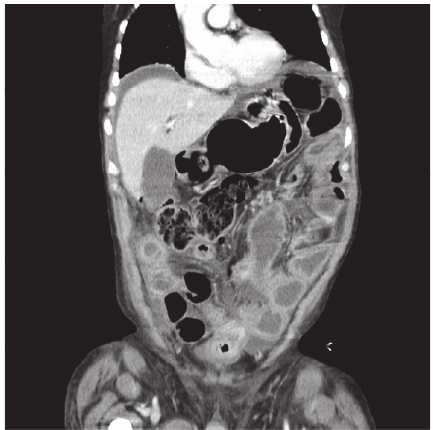
Figure 1: Plain film of abdomen showing dilated small bowel loops. March 2011.